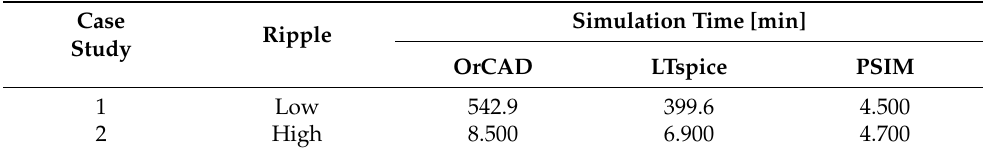
Table 2. Times of the circuit simulations of converter 1 and